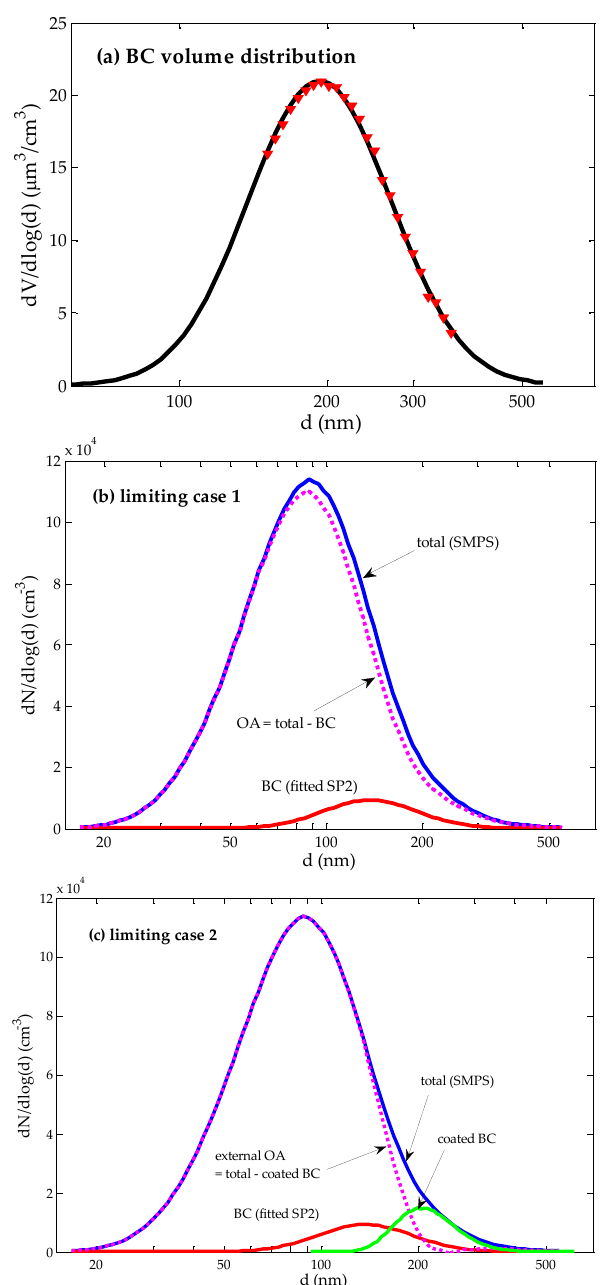
Fig. 3. Measured size distributions from fresh oak experiment. (a) BC volume distribution inferred from SP2 measurements (red dia- monds) and lognormal fit (solid black). (b) Total (SMPS), BC (fit to SP2 data), and OA (difference between total and BC) number distri- butions for limiting case 1 (external-mixing). (c) Total, externally- mixed OA, and internally-mixed (BC coated with OA) number dis- tributions for limiting case 2.